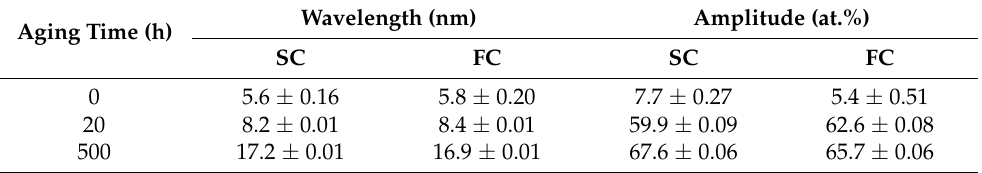
Figure 3. SANS intensity ( a – c ) and NSI ( d – f ) of SDSS 2507 ex situ aged at 475 °C (note that the y -axes of ( d – f ) are different). Table 3. Spinodal wavelength and phase separation amplitude of the samples aged ex situ at 475 °C.